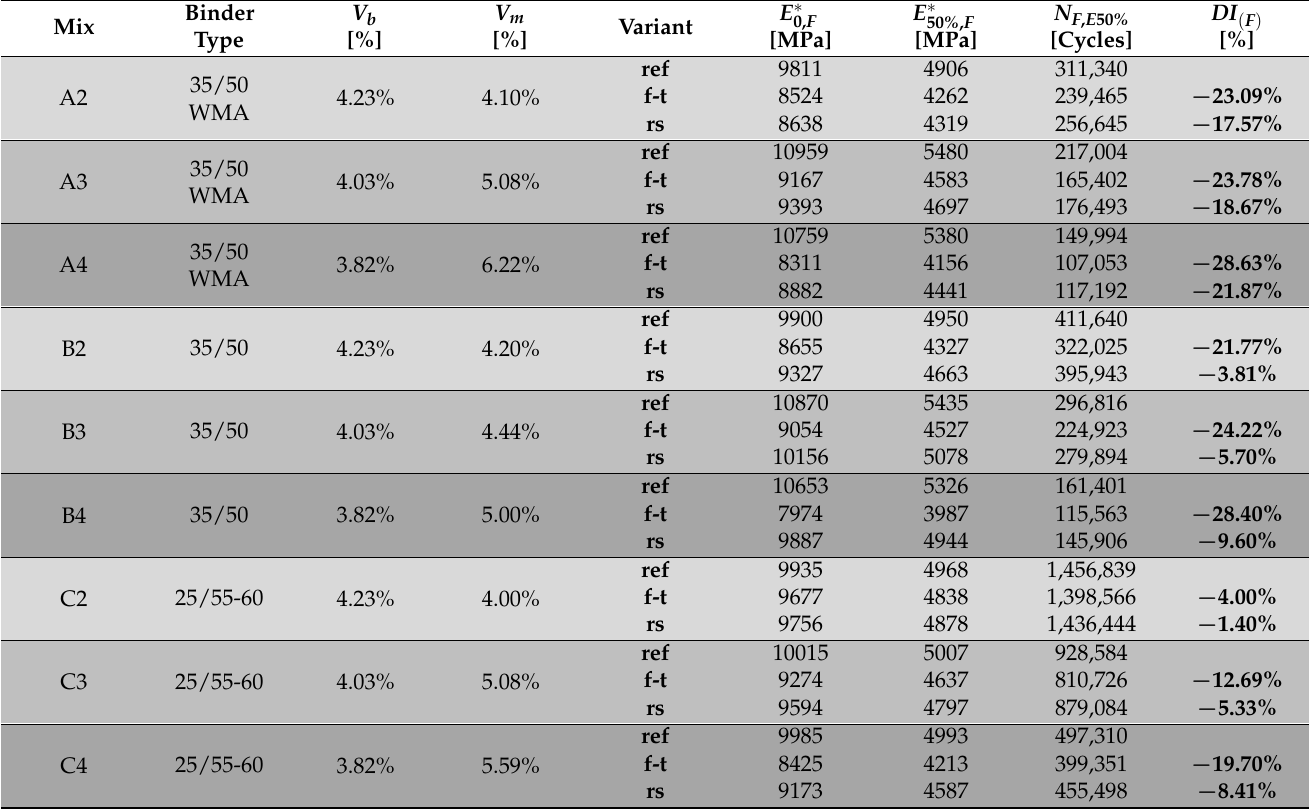
Table 3. Comprehensive fatigue test